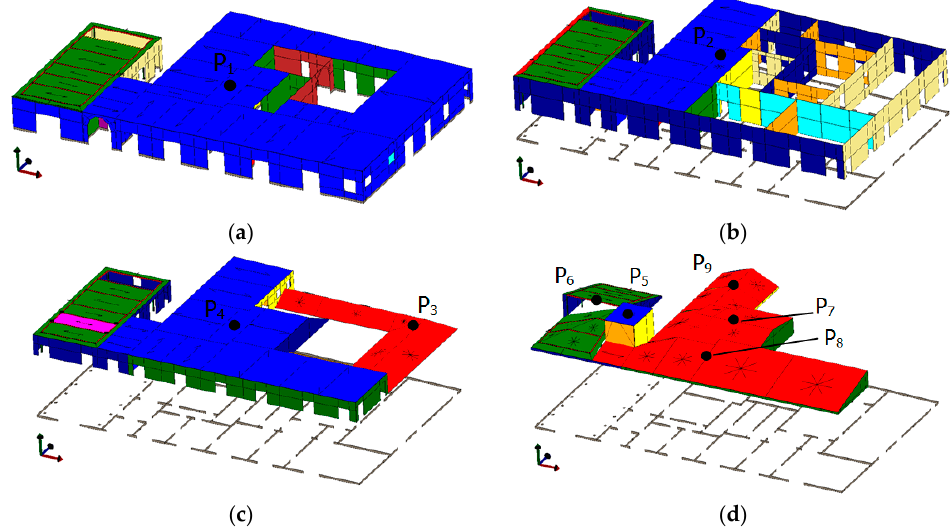
Figure 12. Control points scheme; ( a ) First level: 3.50 m; ( b ) Second level: 7.50 m; ( c ) Third level: 10.20 m; ( d ) Fourth level: 14.45 m.